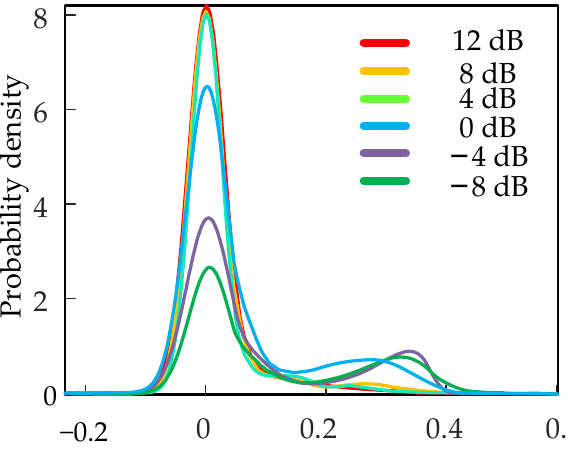
− 0.2 Figure 10. Total uncertainty distribution. Figure 10. Total uncertainty distribution.